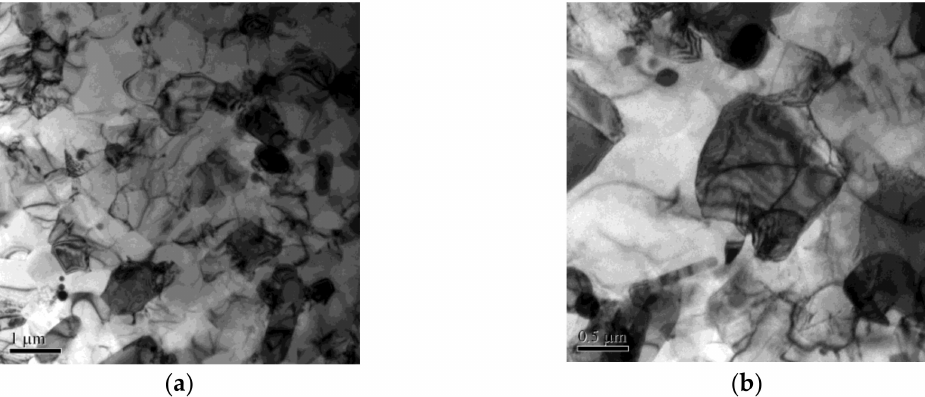
Figure 8. TEM images of alloy N2 at 96% cold rolling reduction. ( a ) with 2550 times magnification and ( b ) with 5000 times